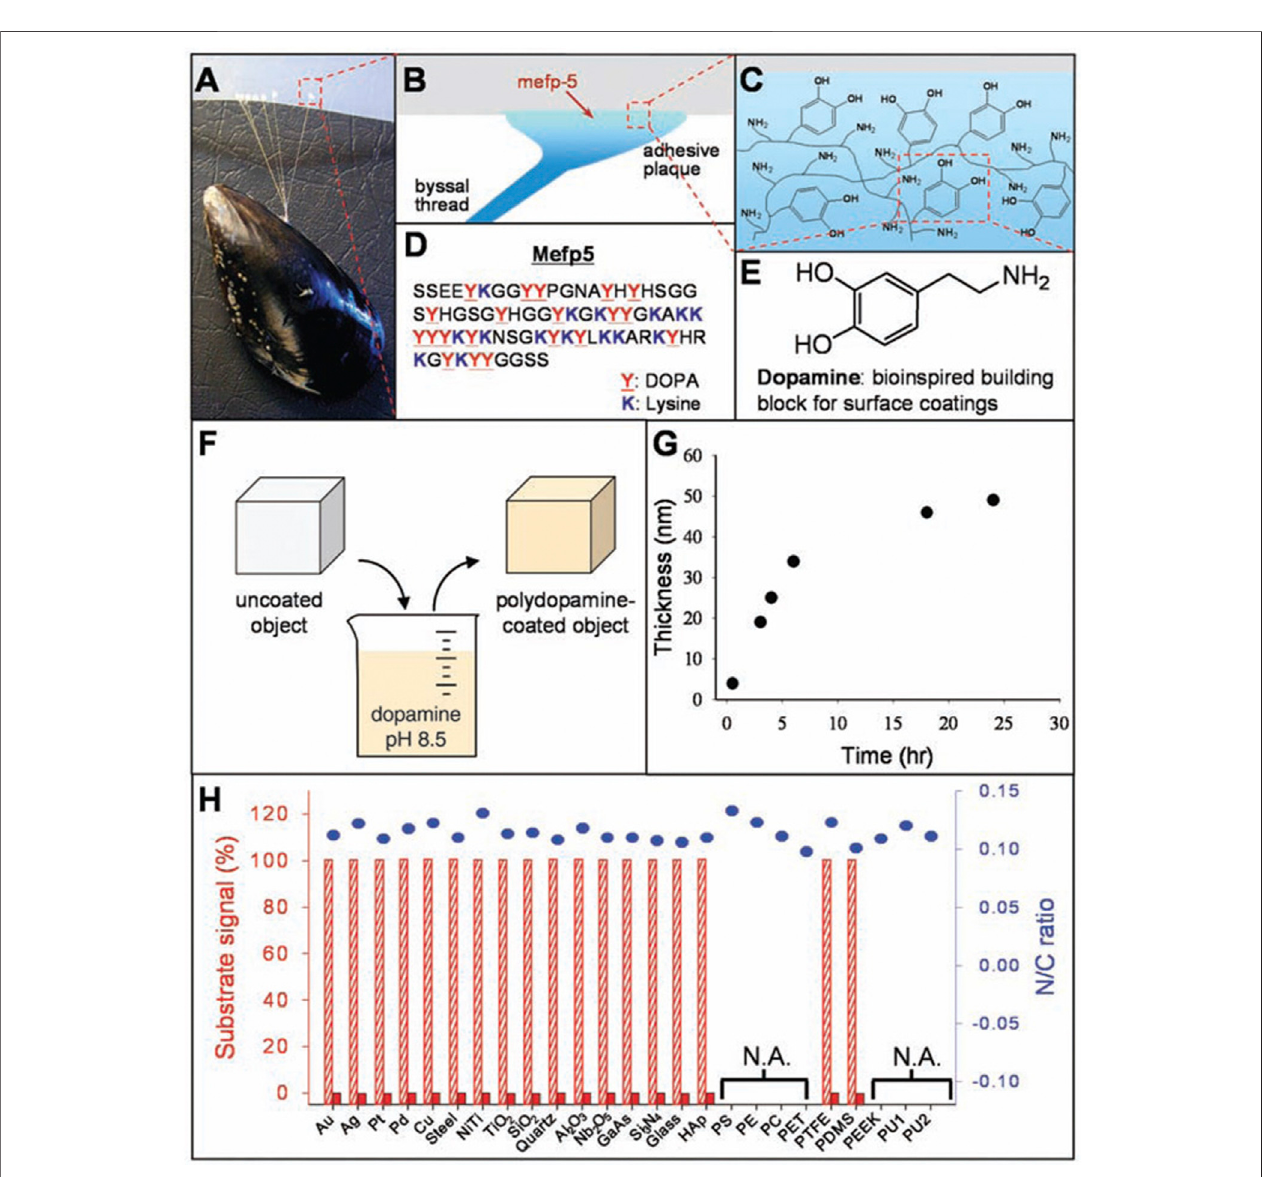
FIGURE1| TheformationofPDAcoatingsontoplentyofmaterials ’ surfaces. (A) Photographofamusselattached toPTFE. (B , C) InterfaciallocationofMefp-5,as well as the representation of catechol and amine groups. (D) The sequence of amino acid in Mefp-5. (E) DA contains same functional catechol and amine groups. (F) A schematic illustration of PDA deposition. (G) Thickness of PDA coating. (H) XPS evaluation of PDA-coated surfaces (Lee et al., 2007). Copyright 2007, The American Association for the Advancement of Science.